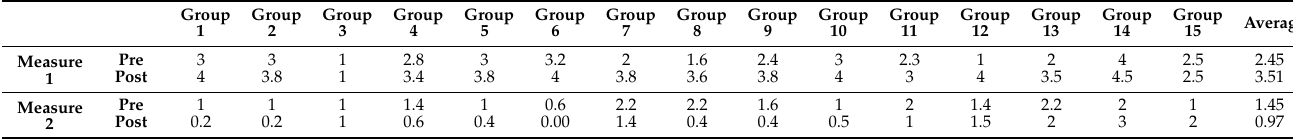
Table 9. Measures of shared knowledge and discrepancy in